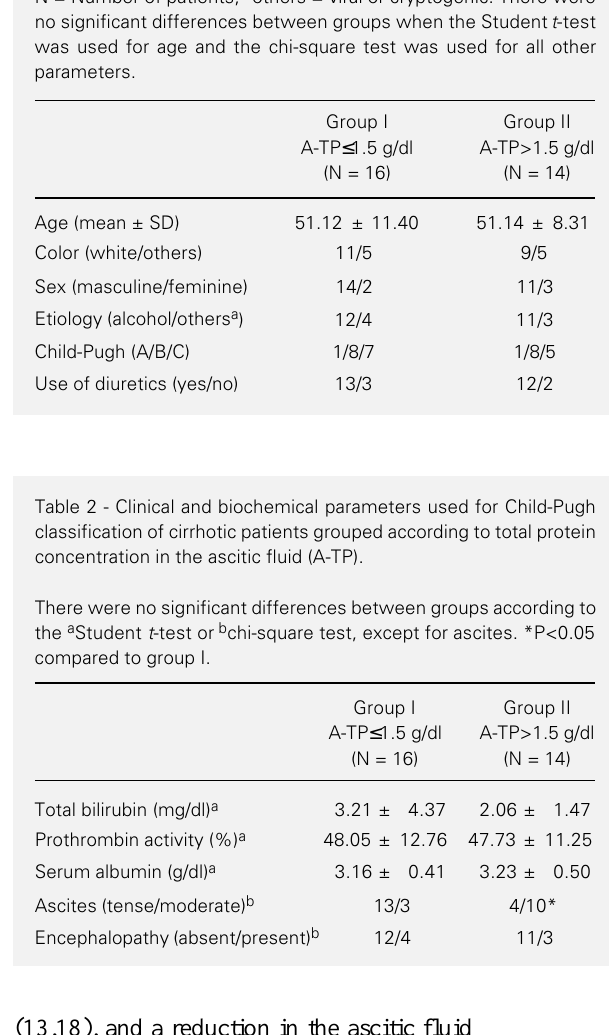
Table 1 - Age, color, sex, etiology, Child-Pugh classification and use of diuretics among cirrhotic patients grouped according to total protein concentration in the ascitic fluid (A-TP).